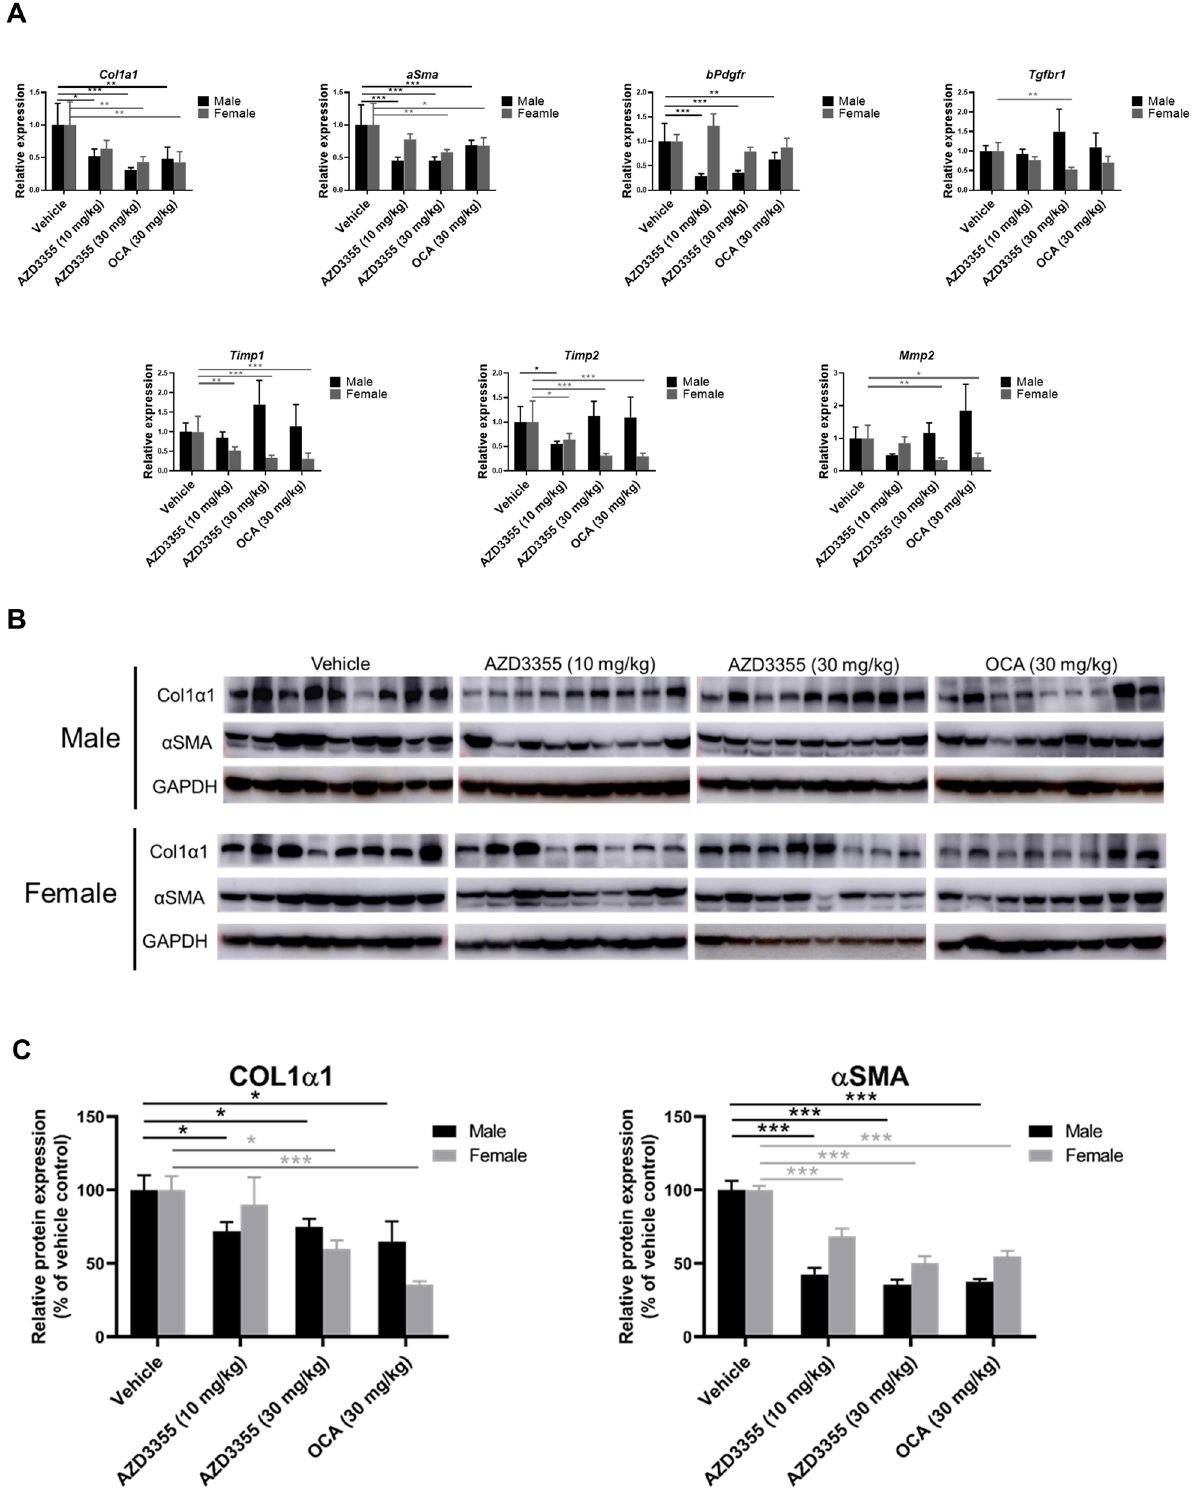
Figure 5. Expression of hepatic fibrogenic genes and proteins are down-regulated by AZD3355 in a murine NASH model. ( A ) Expression of fibrogenic mRNAs in male (black bar) or female (gray bar) murine liver tissues was quantified by RT-qPCR. Data was normalized to GAPDH and expressed relative to livers from the vehicle- treated group. ( B ) Western blots for Col1α1, αSMA and GAPDH in male and female mice from whole liver lysates. ( C ) Relative protein expression compared to the vehicle-treated group was quantified by densitometry of respective Western blots bands, and GAPDH was used as internal control. Vehicle: n = 9 male, 8 female; AZD3355 (10 mg/kg): n = 9 male, 8 female; AZD3355 (30 mg/kg): n = 9 male, 8 female; OCA (30 mg/kg): n = 9 male, 8 female animals. Results were expressed as means ± SEM. * p < 0.05, ** p < 0.01, *** p <